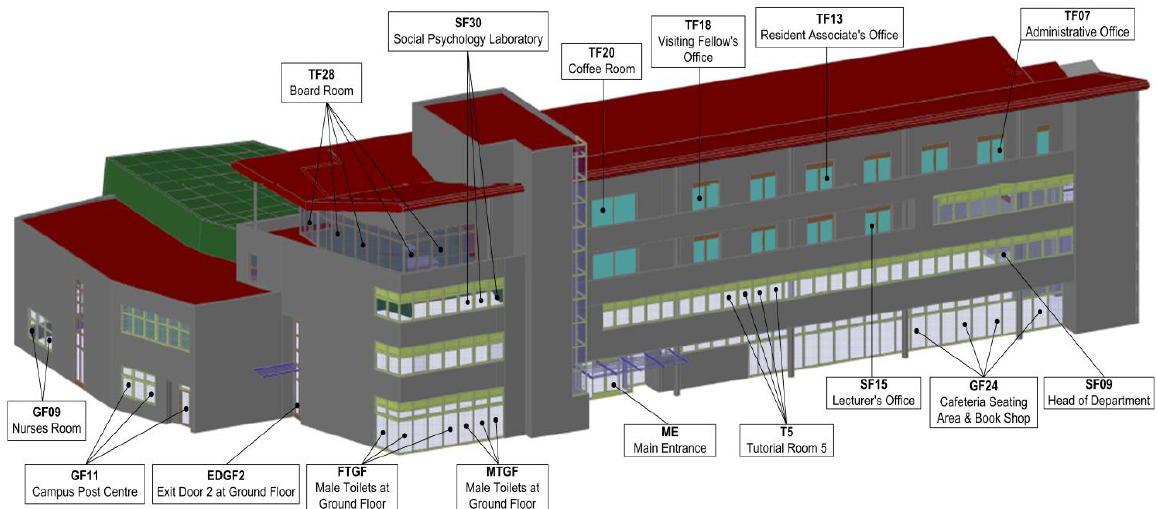
Figure 5. A true 3D (geometrically accurate) model of a campus building derived from detailed laser scanning. Individual features are stored separately in the